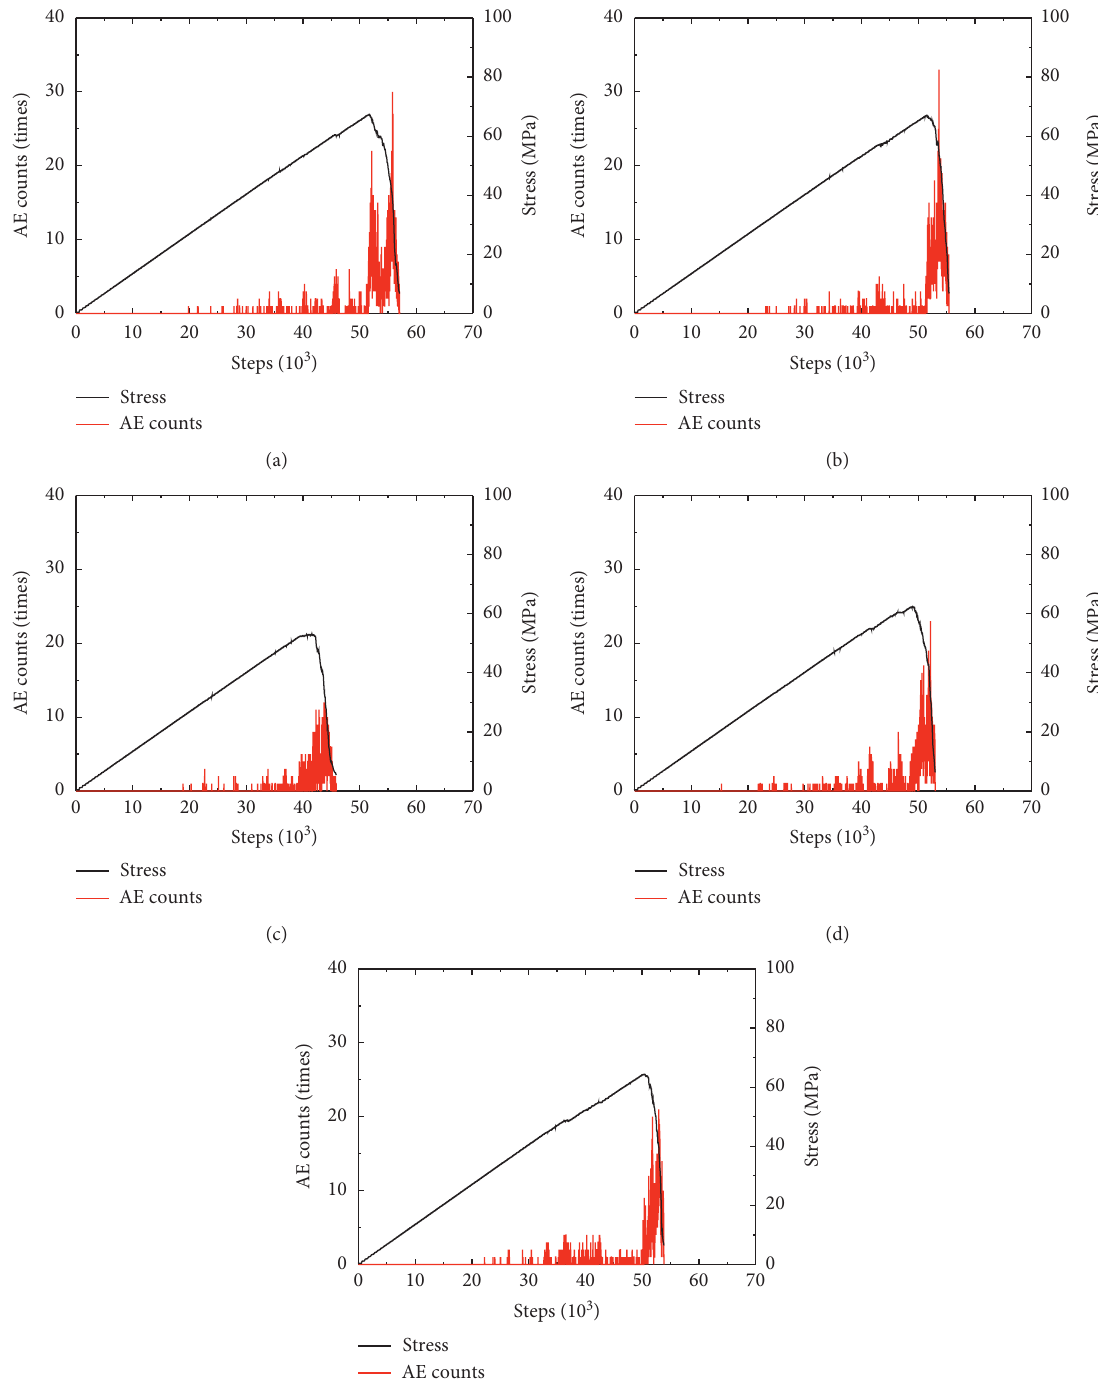
Figure 18: Stress-time-AE counts of samples with different boreholes dip angle. The α of (a), (b), (c), (d), and (e) are 0 ° , 20 ° , 40 ° , 60 ° , and 80 ° ,